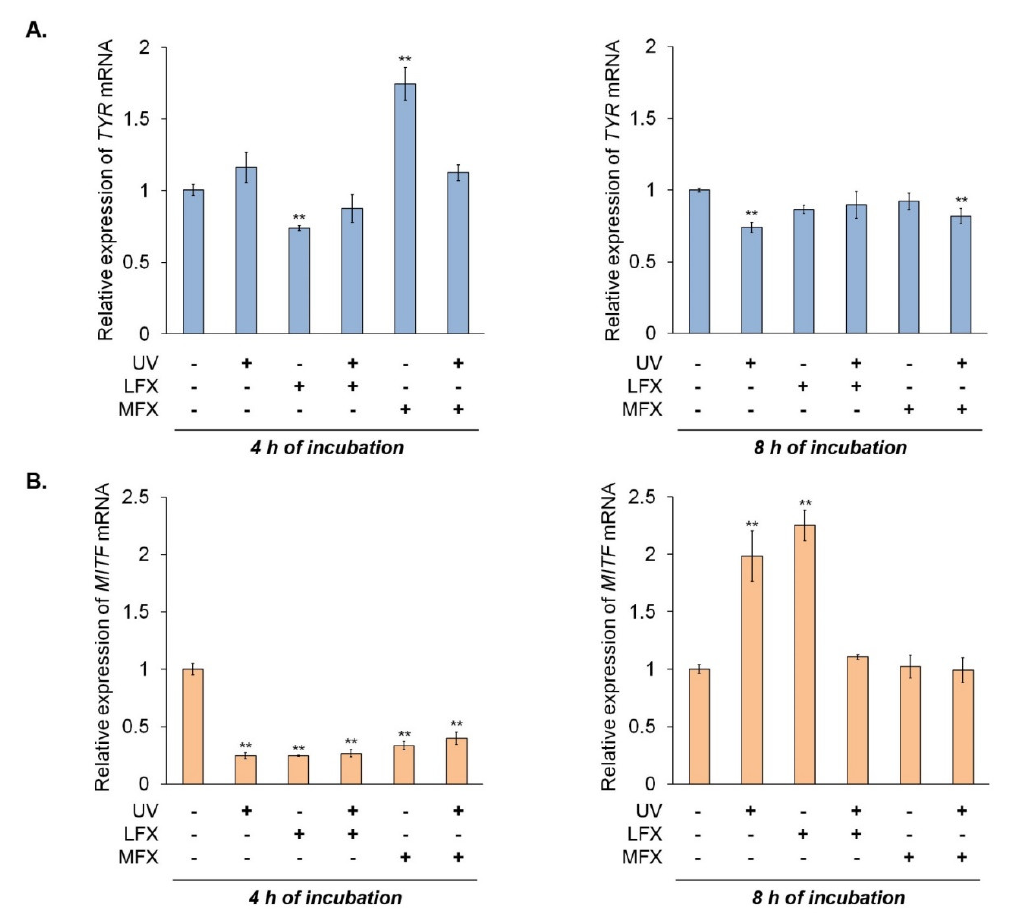
Figure 7. Fluoroquinolones alone and plus UVA radiation affect the expression of tyrosinase ( TYR ) and microphthalmia- associated transcription factor ( MITF ) at mRNA level in melanocytes. The cells were exposed to lomefloxacin (LFX) in concentration of 0.05 mM and moxifloxacin (MFX) in concentration of 0.1 mM. The mRNA levels of TYR ( A ) and MITF ( B ) were determined by RT-qPCR after 4 h and 8 h since the irradiation. Bar graph represents mean ± SD from three independent experiments. ** p < 0.01 vs control.